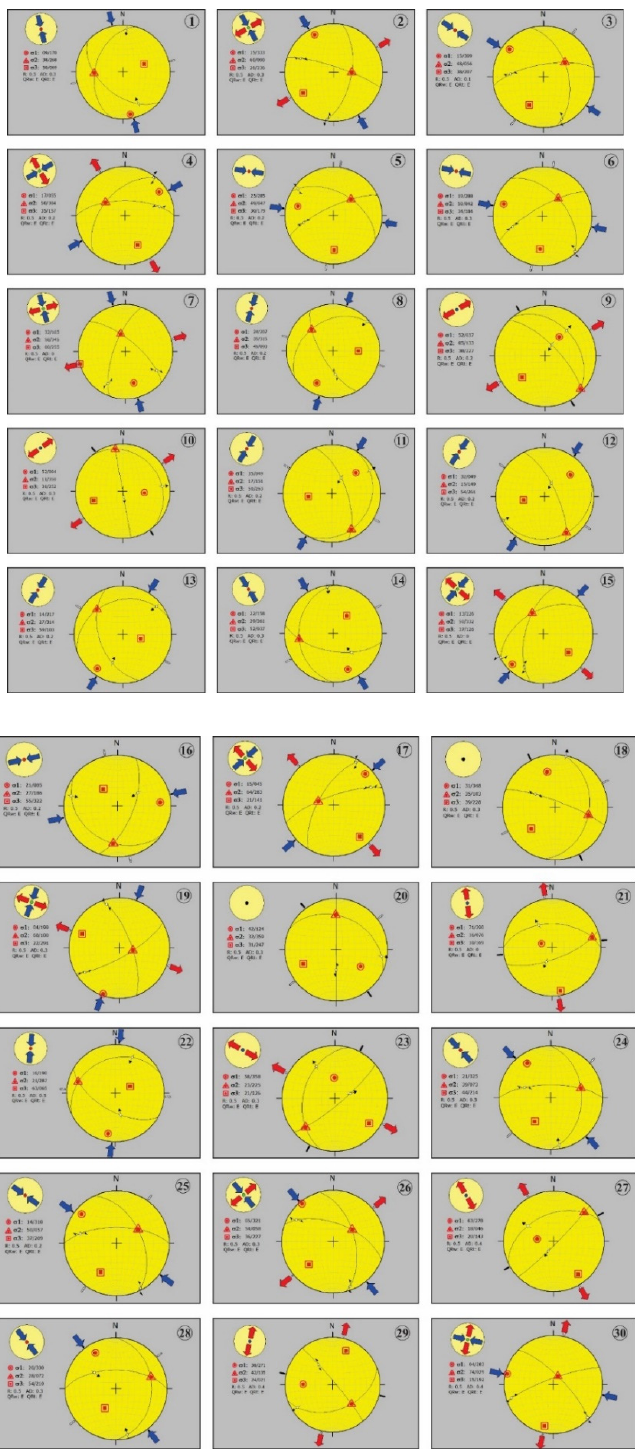
Figure 7. Stereographic projection of conjugate fracture data of 30 stations from Besham to Dasu along the KKH. Strike ‐ slip stresses are dominant from stations 2 – 7 . Stations 8 – 30 are further divided into minor groups, depicting a dominant compression followed by strike ‐ slip and extensional stresses.